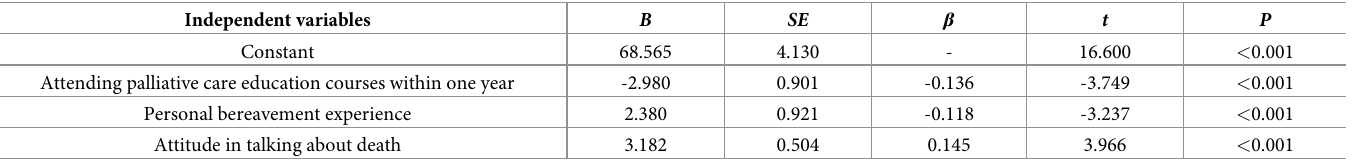
Factors affecting coping with grief The scores of nurses on the coping with grief subscale were taken as the dependent variable, and factors with significance in general data were taken as independent variables. Multiple stepwise regression analysis was conducted with α = 0.05 and α = 0.10 in the entry and exit models, respectively. After the final entry into the equation, the factors were respectively ana- lysed for age, attendance in palliative care education courses within the previous year and atti- tudes about death (Table 6). Table 4. Regression analysis of the DCS of nurses. Independent